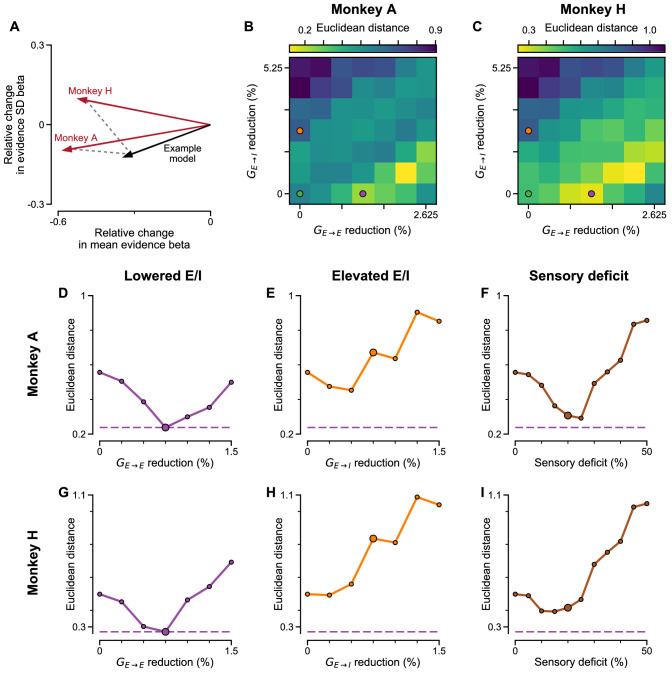
Euclidean distance of various perturbation effects in the circuit model, to the effect of ketamine injections on monkey behaviour.(A) Schematic of the dissimilarity measure. The effect of ketamine perturbation to monkey choice behaviour (with lapse rate accounted for) is represented as the relative change in regression coefficients for mean evidence and evidence SD of monkey under ketamine vs saline (red arrows), and similarly for perturbed models vs control circuit model. The Euclidean distance between the vectors measures the dissimilarity between distinct perturbations. The example model perturbation (black arrow) with weak NMDA-R hypofunction on excitatory neurons (purple dot in B,C), has good cosine similarity and Euclidean distance to the ketamine effect in both monkeys (see B-D,G, Figure 8—figure supplement 4). (B) Circuit models with various degrees of NMDA-R hypofunction on excitatory (GE→E) and inhibitory (GE→I) neurons are considered. In each case, the regression coefficients of mean evidence and evidence standard deviations are compared to that of the control circuit model. The direction of alteration in each perturbed model, in the 2-dimensional space of mean evidence and evidence standard deviations, is compared to the direction of alteration by ketamine injection to Monkey A choice behaviour. A smaller Euclidean distance means the relative extent (and direction) of alteration, to the regression coefficients of mean evidence and evidence standard deviation, is more similar between the perturbations in the circuit model and the monkey data. The green, purple, and orange dots respectively denote the control, lowered E/I, and elevated E/I circuit models used in Figure 7. (C) Same as (B) but with comparisons made with Monkey H choice behaviour. (D) Circuit models with varying degrees of NMDA-R hypofunction on excitatory neurons (GE→E) are considered. In each case, the Euclidean distance between the perturbation vector in the model and Monkey A data are compared, in the same manner as (B). The large dot denotes the perturbation strength used in the lowered E/I model in Figure 7. (E) Same as (D) but with various degrees of NMDA-R hypofunction on inhibitory (GE→I) neurons in the circuit model. The large dot denotes the perturbation strength used in the elevated E/I model in Figure 7. (F) Same as (D) but with various degrees of sensory deficits in the circuit model. The large dot denotes the perturbation strength used in the sensory deficit model in Figure 7. Purple dashed lines indicate the smallest Euclidean distance between ketamine effect on Monkey A and any model perturbations across (D–F) (which is achieved by a lowered E/I model). (G–I) Same as (D–F) but with comparisons made with Monkey H choice behaviour.